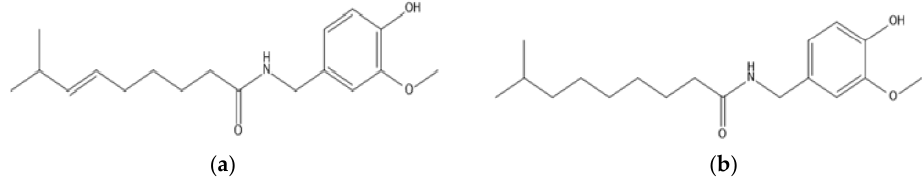
Figure 1. Chemical structure of capsaicin ( a ) and dihydrocapsaicin ( b ).